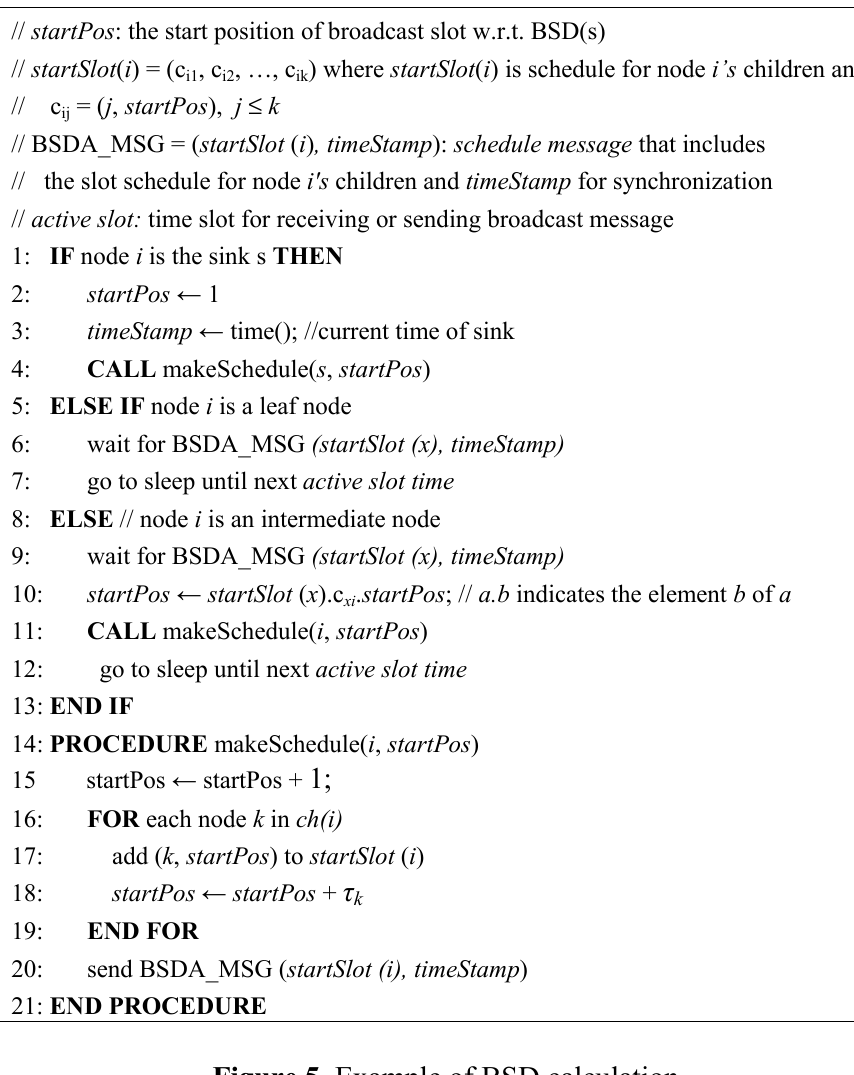
Figure 5. Example of BSD